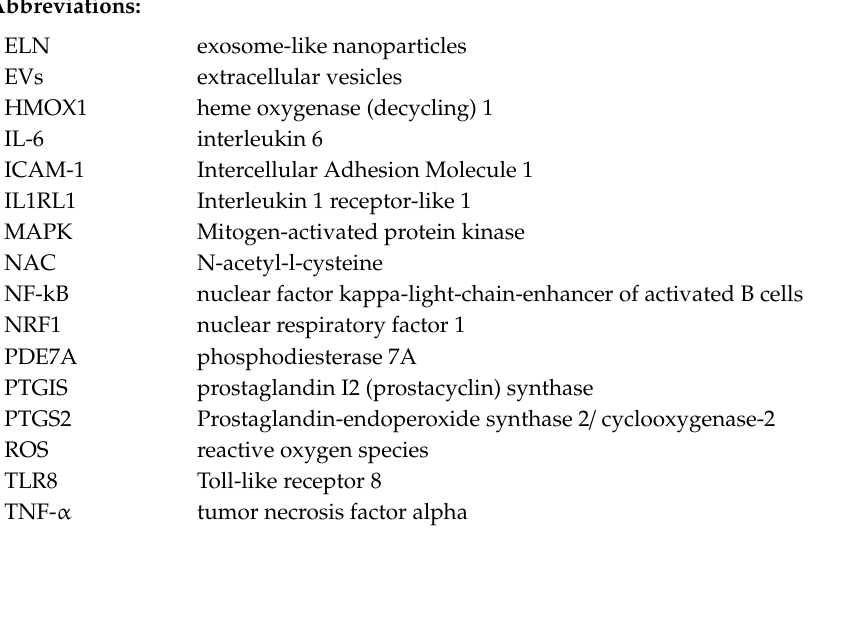
Figure S1: Content of cyanidin-3-0-glucoside equivalent (C3G) in blueberry juice, Figure S2: Protein content of B-ELNs isolated from di ff erent BB juice. Bar represent protein amount (mg / mL) for each B-ELNs isolation, Table S1: List of genes and probes selected to undergo to real-time qPCR analysis, Table S2: Enrichment canonical pathways in EA.hy926 pretreated with B-ELNs the exposed to TNF- α , Table S3 KEGG pathways potentially altered by the 29 human genes that might be a ff ected by B-ELNs (Referred to Figure 8a), Table S4: GO family (Biological Process) potentially altered by the 29 human genes that might be a ff ected by B-ELNs (Referred to Figure 8b), Table S5: List of putative targets for selected miRNAs predicted by psRNATarget